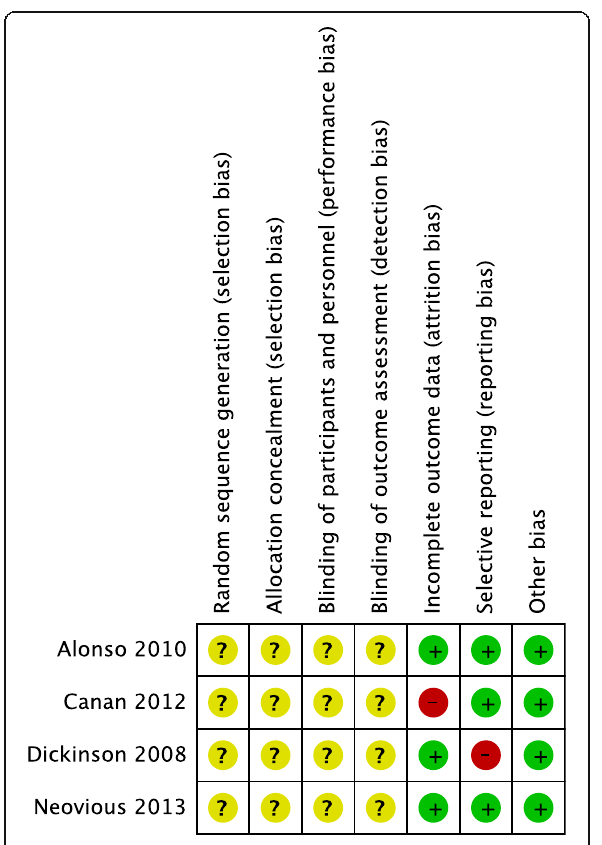
Fig. 1 Risk of bias summary: risk of bias item for each included study according to the Cochrane Collaboration